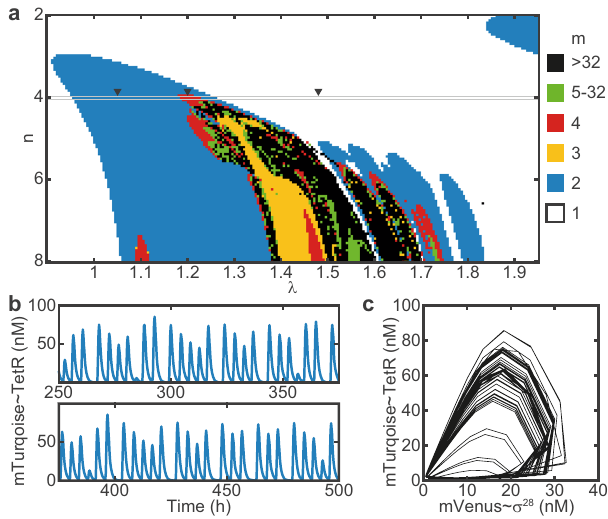
Fig. 7 Simulations predict chaotic dynamics. a Two-dimensional bifurcation diagram showing the rotation number m for varying n and λ . With increasing n , the dynamics become increasingly more complex, over a broader range of λ . b Chaotic trajectory (endogenous TetR) and c phase portrait of the corresponding strange attractor for n = 8, λ = 1.5542. Parameter values, except n , are the same as in Fig. The bifurcation analysis reveals that for low λ the system displays 1-cycles, then undergoes two period doublings to show a 4-cycle around λ = 1.2, followed by period ‘ halvings ’ and again 1-cycles at high values of λ . Qualitatively, the experimentally recorded phase space trajectories (Fig. 6b, Supplementary Figs. 2 and 3) match the corresponding simulated trajectories for the same λ values (Fig. 6c) remarkably well . One interesting feature is that for λ = 1.05 both experiment and simulation display a 2-cycle that is degenerate in the dynamics of TetR, i.e., the second maximum is not visible, but the period is doubled.